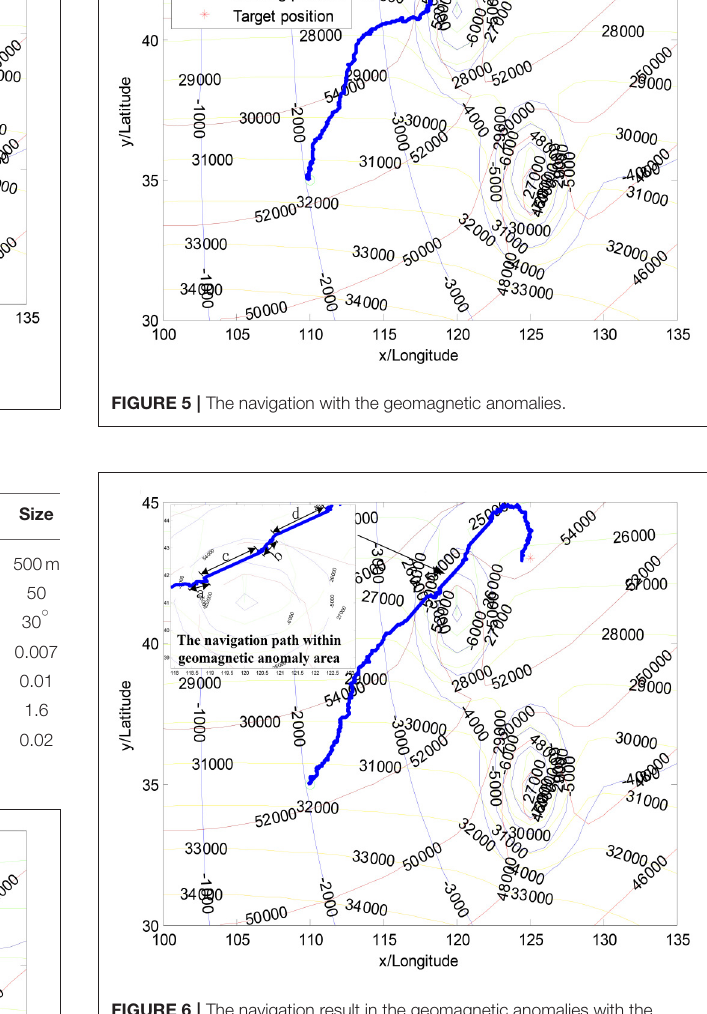
FIGURE 6 | The navigation result in the geomagnetic anomalies with the proposed